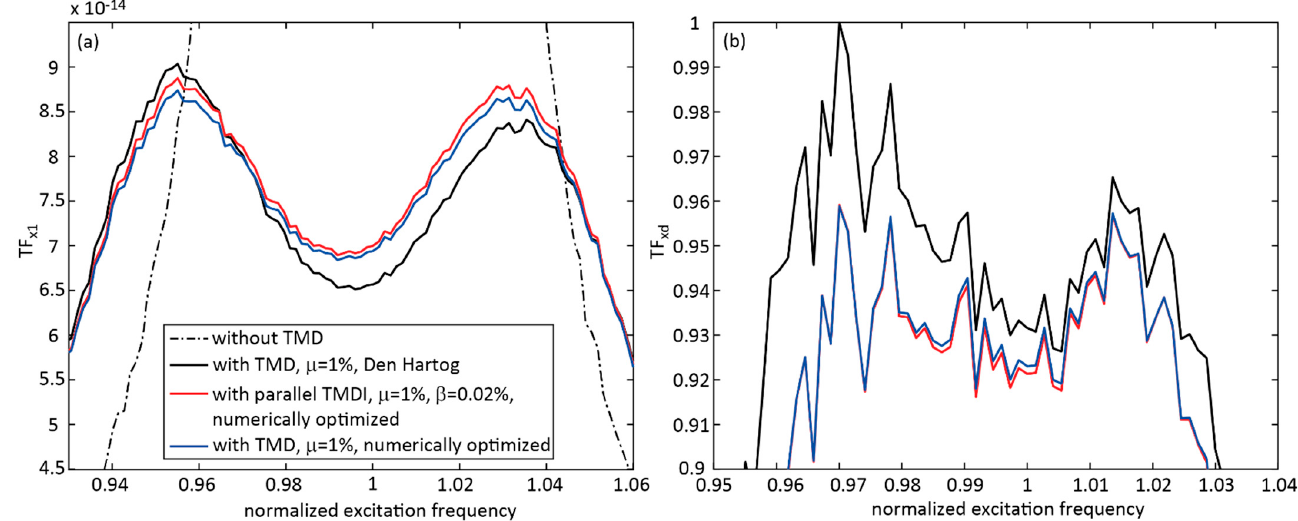
Figure 9. Performances of TMDI with inerter in parallel to stiffness and viscous damper ( 𝜇 = 1%, 𝛽 = 0.02%, numerically optimized parameters), TMD ( 𝜇 = 1%, Den Hartog parameters) and TMD ( 𝜇 = 1%, numerically optimized parameters) for random excitation: (a) primary structure normalized displacement response and (b) normalized damper relative motion response